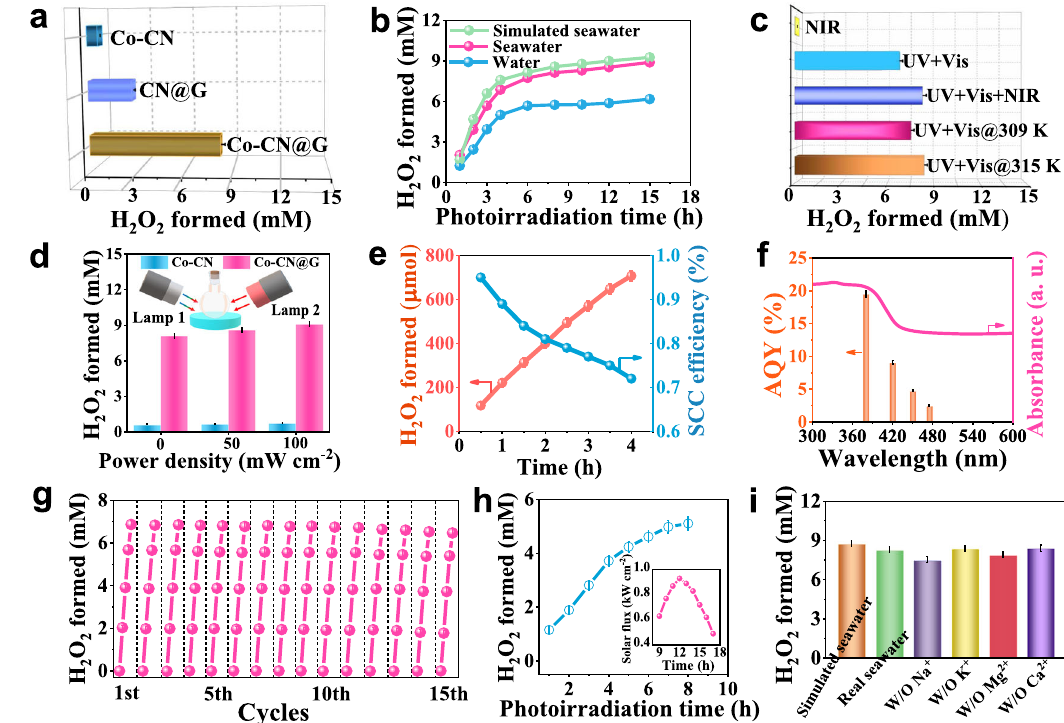
Fig. 3|PhotocatalyticpropertiesofCo – CN@G.a Amountsof H 2 O 2 generatedby 10h of photoirradiation under simulated sunlight (AM 1.5G, 100mWcm − 2 ) on different photocatalysts in natural seawater. b Time course of H 2 O 2 photo- production by Co – CN@G. c Amounts of H 2 O 2 generated by 10h of photoirradia- tion on Co – CN@G under different photoirradiation in natural seawater.